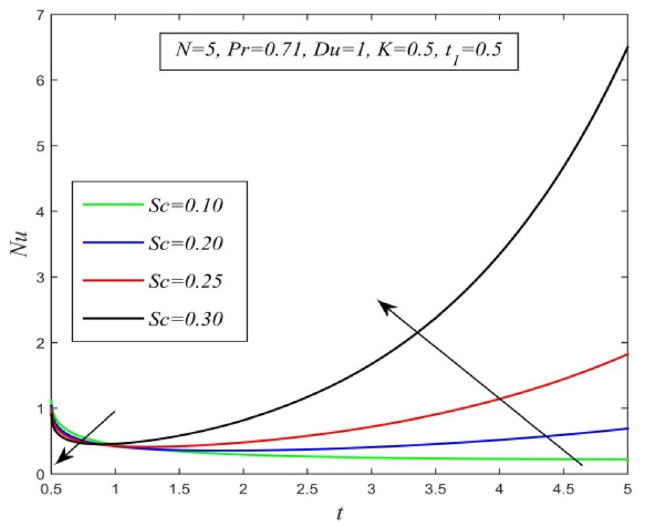
Figure 27. Nu versus t for different Sc and N = 5, Pr = 0.71, Du = 0.5, K = 0.5, t 1 = 0.5.